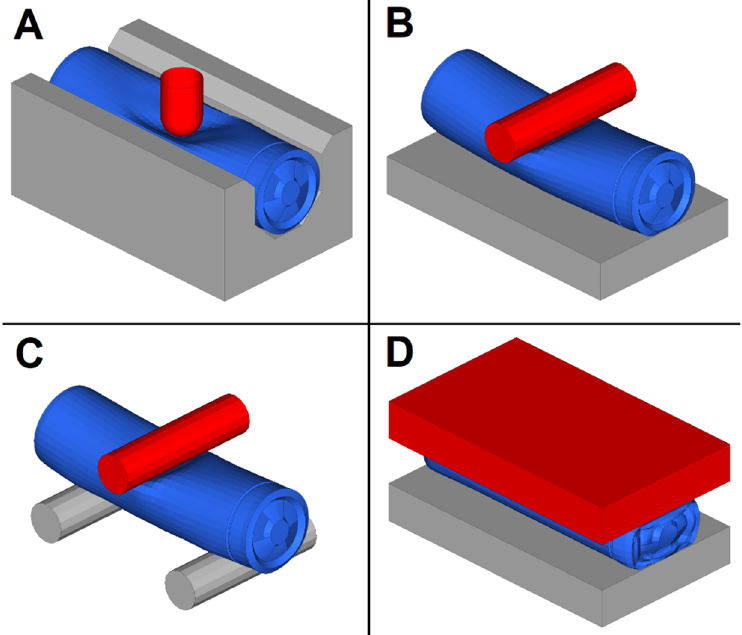
Figure 1. ( A ) Indentation by a hemispherical punch; ( B ) lateral indentation by a cylindrical rod; ( C ) three-point bending and ( D ) compression between two flat plates.